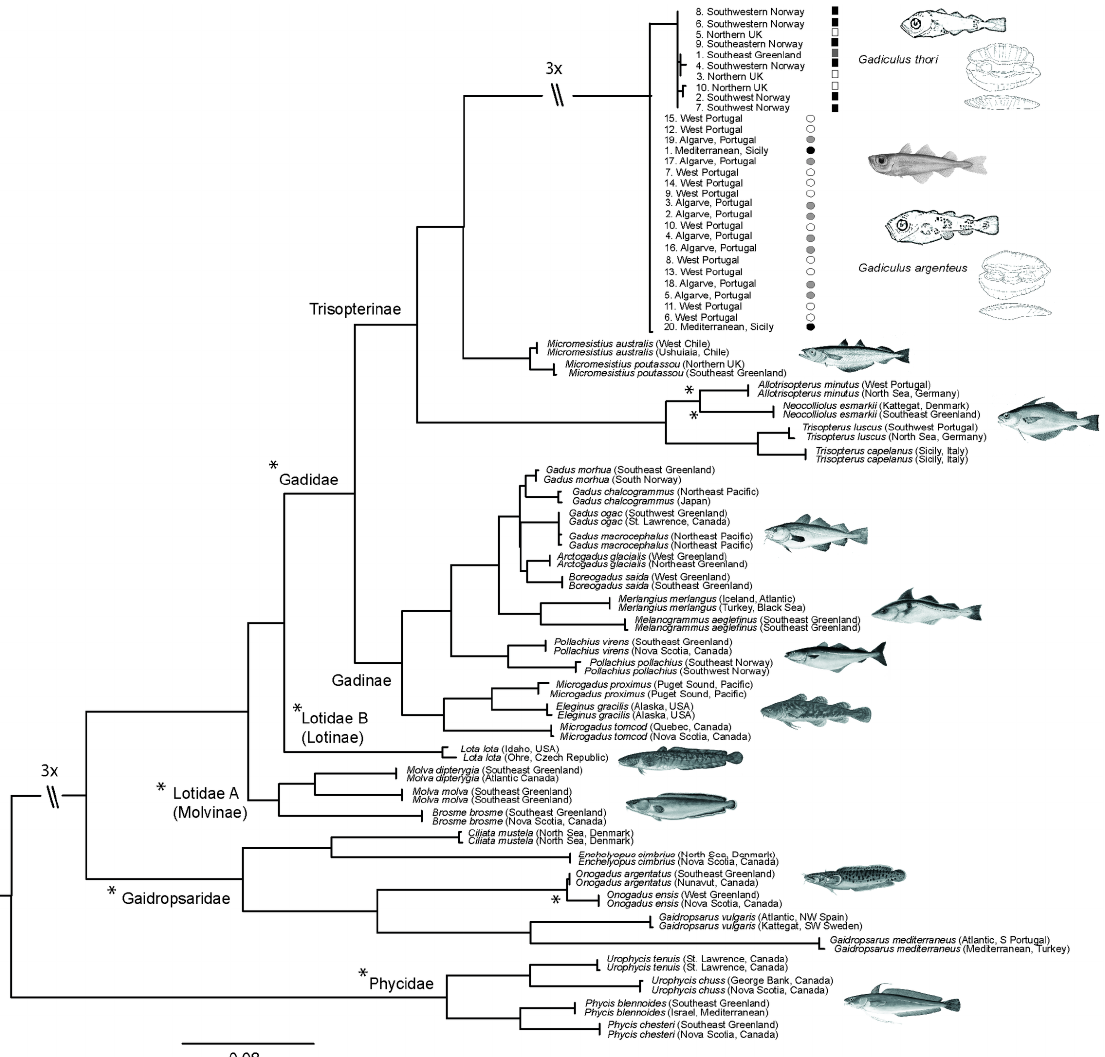
Figure 8. Distance-based K2P neighbour-joining cladogram of the family Gadidae, including taxa of Lotidae, Gaidropsaridae and Phycidae employed as outgroups. We note that the cladogram is intended for molecular taxonomy and not an attempt at resolving Gadidae phylogeny, hence the omission of support values. All currently valid Gadidae taxa are included, except Eleginus nawaga (Pallas, 1814) (no Cox1 available). Catch locations are noted in parentheses. Numbers listed of Gadiculus spp. correspond with Figure 3 and Table 2. Double bars ( \\ ) indicate a three-fold shortening of the branches for practical purposes only. Asterisk (*) denotes classificatory names used in this Figure that are supported by otoliths, although currently not employed in morphological and molecular taxonomy (see main text sections). It is of note that the longest branch present in the family Gadidae is representing the Gadiculus lineage, having two extant taxa and several extinct taxa. Post-larvae (Schmidt [17]) and general adult otolith morphology (this study) are included for both Gadiculus taxa. Gadiculus thori otolith: SL 150, OL 7.85; G. argenteus otolith: SL 123, OL: 7.56.